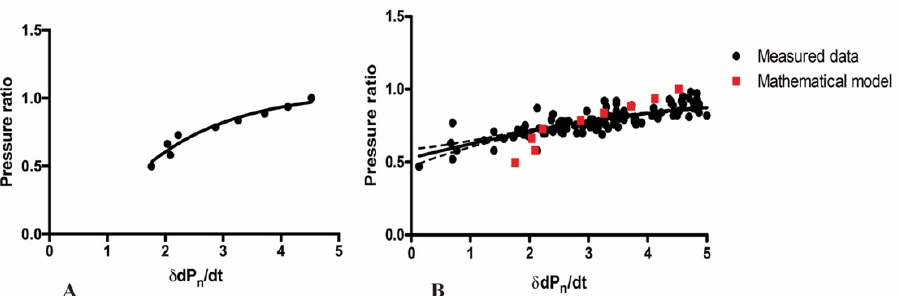
Figure 3. Relationship of FFR and RPR vs. δ dP n /dt and diagnostic characteristics of δ dP n /dt using FFR as a reference standard. ( A , B ). Scatter plots showing FFR as a function of the hyperaemic δ dP n /dt ( A ) and that of δ dP n /dt measured at rest ( B ). Here, r is calculated by applying Spearman’s correlation. ( C ). A scatter plot showing RPR as a function of the distal δ dP n /dt measured at rest. Here, r is calculated by applying Spearman’s correlation. ( D ). Receiver operating characteristic curve (ROC) for hyperaemic and resting δ dP n /dt vs. FFR. ( E ). Relationship between individual FFR values grouped into positive (<0.8) and negative ( ≥ 0.8) subsets and δ dP n /dt (hyperaemic). ( F ). Scatter plots showing the phase pressure ratio as a function of δ dP n /dt. Here, r is calculated by applying Spearman’s correlation. Abbreviations: FFR = Fractional flow reserve; δ dP n /dt = local amplitude around the dicrotic notch on the derivative curve of the distal intracoronary pressure trace; RPR = Resting pressure ratio; ROC = receiver operating curve.